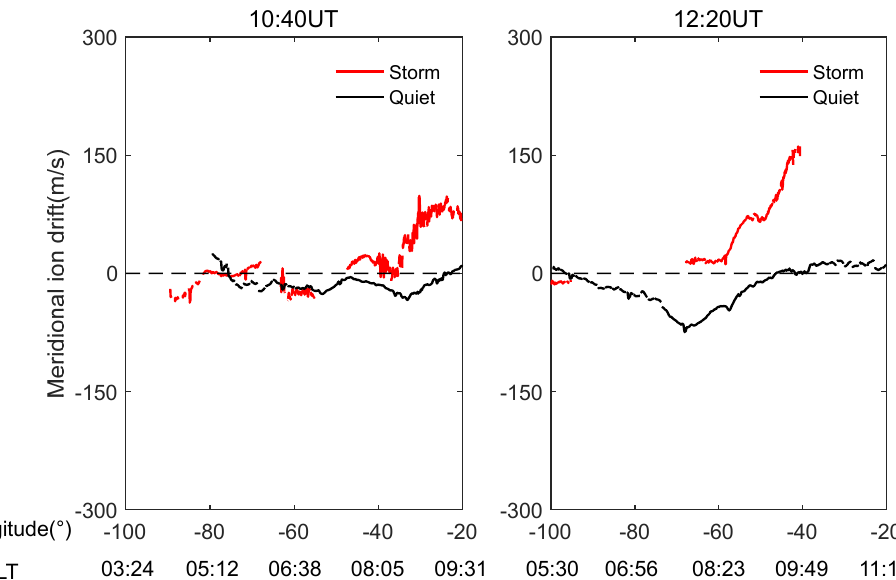
Figure 9. Comparison of ICON meridional ion drifts (within the geomagnetic meridional plane, perpendicular to the field line, positive outward) between the quiet day (3 November; black line) and storm day (4 November; red line). The second row of the X-axis denotes the local time at which the ICON satellite passed the longitudes in the first row of X-axis. The satellite trajectories are the same as those in Figure 8.